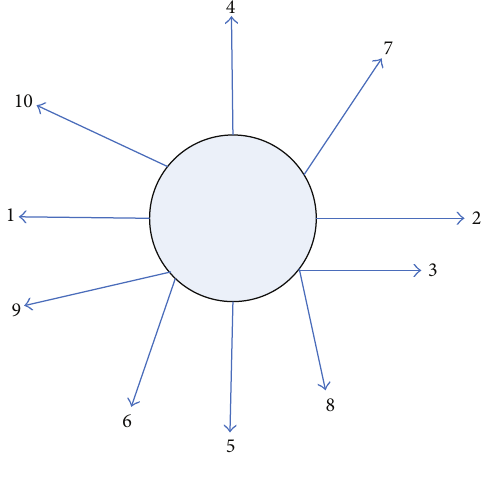
Figure 12: Routing port